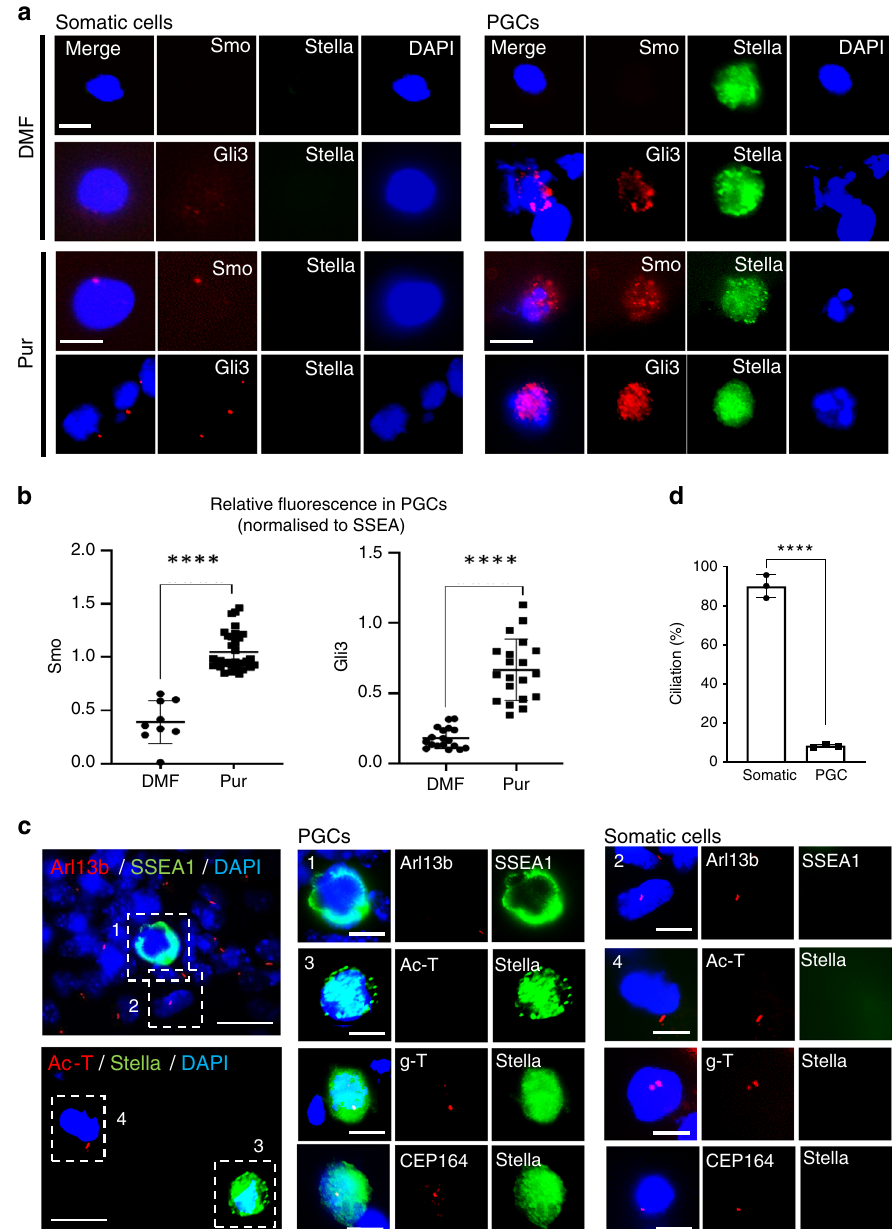
Fig. 4 PGCs are naturally unciliated but still responsive to Hh signalling. a Primary cultures of GR were treated with DMF or Pur for 18 h and analysed by immuno fl uorescence staining for Smo and Gli3. The positive and negative staining for Stella, a germ cell marker, distinguished PGCs and somatic cells, respectively. The merged images are shown without Stella signal for improved clarity. Representative images from three biologically independent experiments are shown. Scale bar, 10 µ m. b Dot plots showing the relative fl uorescence intensity values of Smo and Gli3 signal observed in PGCs treated with DMF or Pur, which were normalised to the fl uorescence intensity values of Stella in each cell. Unpaired t -test with Welch ’ s correction indicates a signi fi cant increase in Smo (DMF ( n = 9), Pur ( n = 31), P < 0.0001) and Gli3 (DMF ( n = 18), Pur ( n = 20), P < 0.0001). c Cilia staining of primary cultures of dissected E10.5 mouse GR tissues. Arl13b and acetylated tubulin are used for axoneme staining and gamma-tubulin and CEP164 are used for basal body staining. SSEA1 and Stella are used as germ cell markers. Representative images from three independent experiments are shown. Scale bar, 10 µ m. d Ciliation frequency of the PGCs ( n = 158) and the somatic cells ( n = 971) observed from GR cultures. Error bars represent SD of three independent experiments. Each data point represents one experiment. Unpaired t -test, two-tailed (**** P < 0.0001). Source data are provided as a Source Data fi